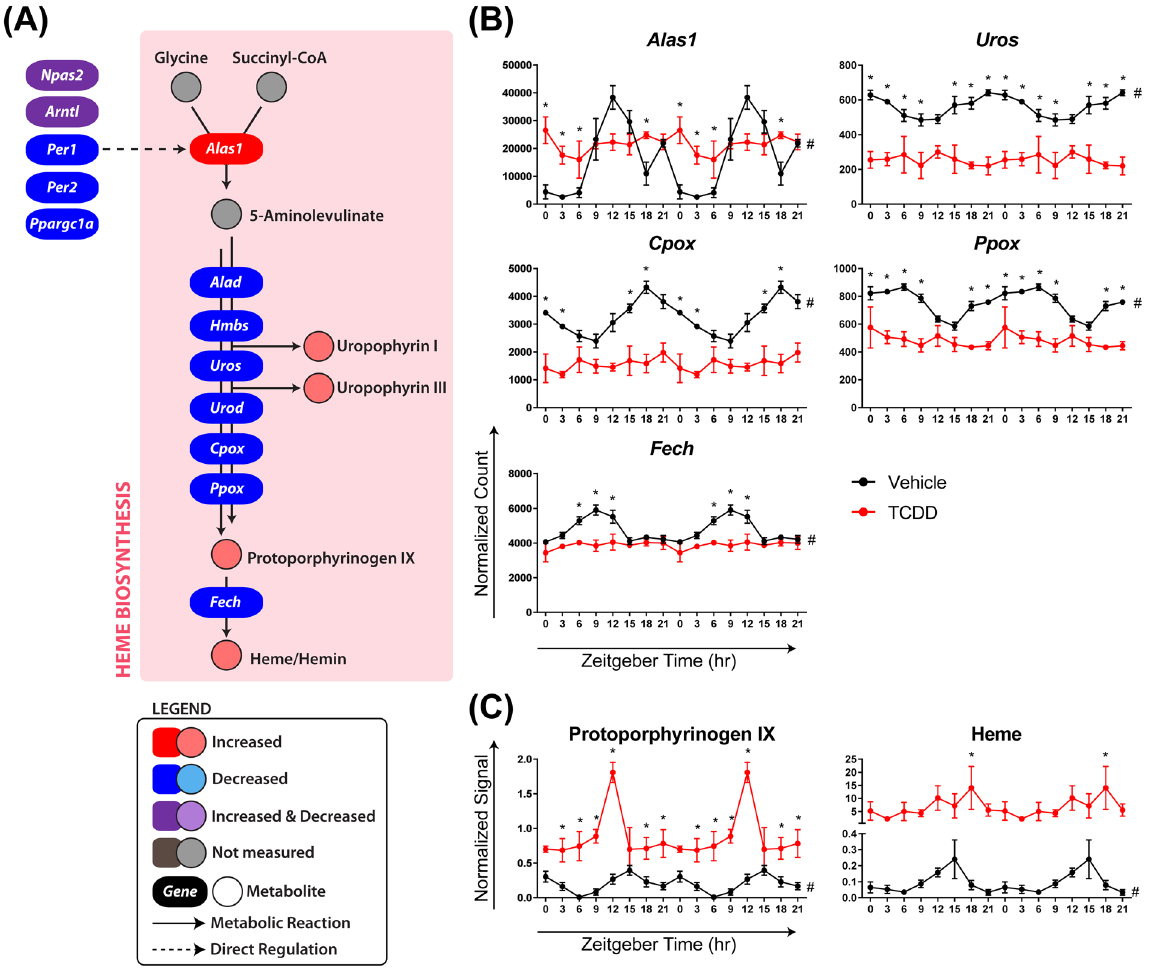
Figure 10. TCDD disrupts the circadian regulation of heme biosynthesis. Male C57BL/6 mice were orally gavaged with sesame oil vehicle or 30 µ g/kg TCDD every 4 days for 28 days. ( A ) The effect of TCDD on hepatic heme biosynthesis. TCDD-elicited changes in hepatic ( B ) genes and ( C ) metabolites involved in heme biosynthesis. For genes, data points represent the average of 3 individual mice ± standard error of the mean (SEM), where posterior probabilities ( * P1(t) ≥ 0.80) comparing vehicle and TCDD were determined using an empirical Bayes method. For metabolites, data points represent the average of 3–5 individual mice ± SEM, where statistical significance ( * p ≤ 0.05) between vehicle and TCDD was determined using a 2-way ANOVA analysis followed by Sidak’s multiple comparison test. Diurnal rhythmicity was assessed using JTK_CYCLE (# BH q ≤ 0.1). Data are double-plotted along the x-axis for better visualization of